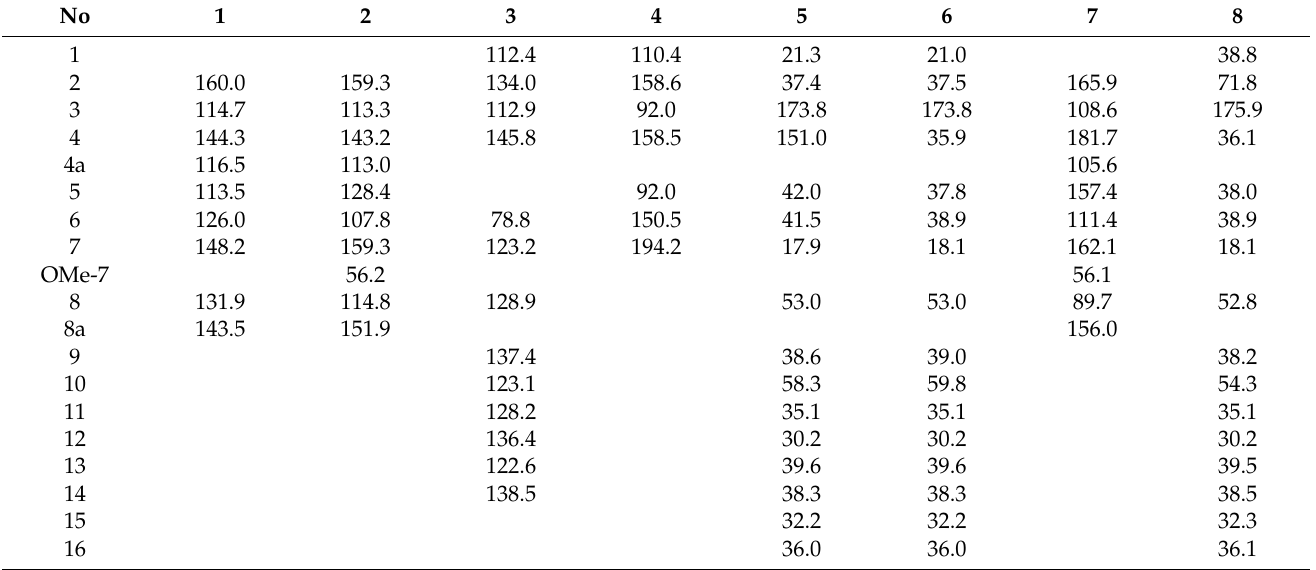
Table 2. 13 C NMR data for Compounds 1 – 8 ( δ in ppm, 125 MHz for 13 C NMR in CDCl 3